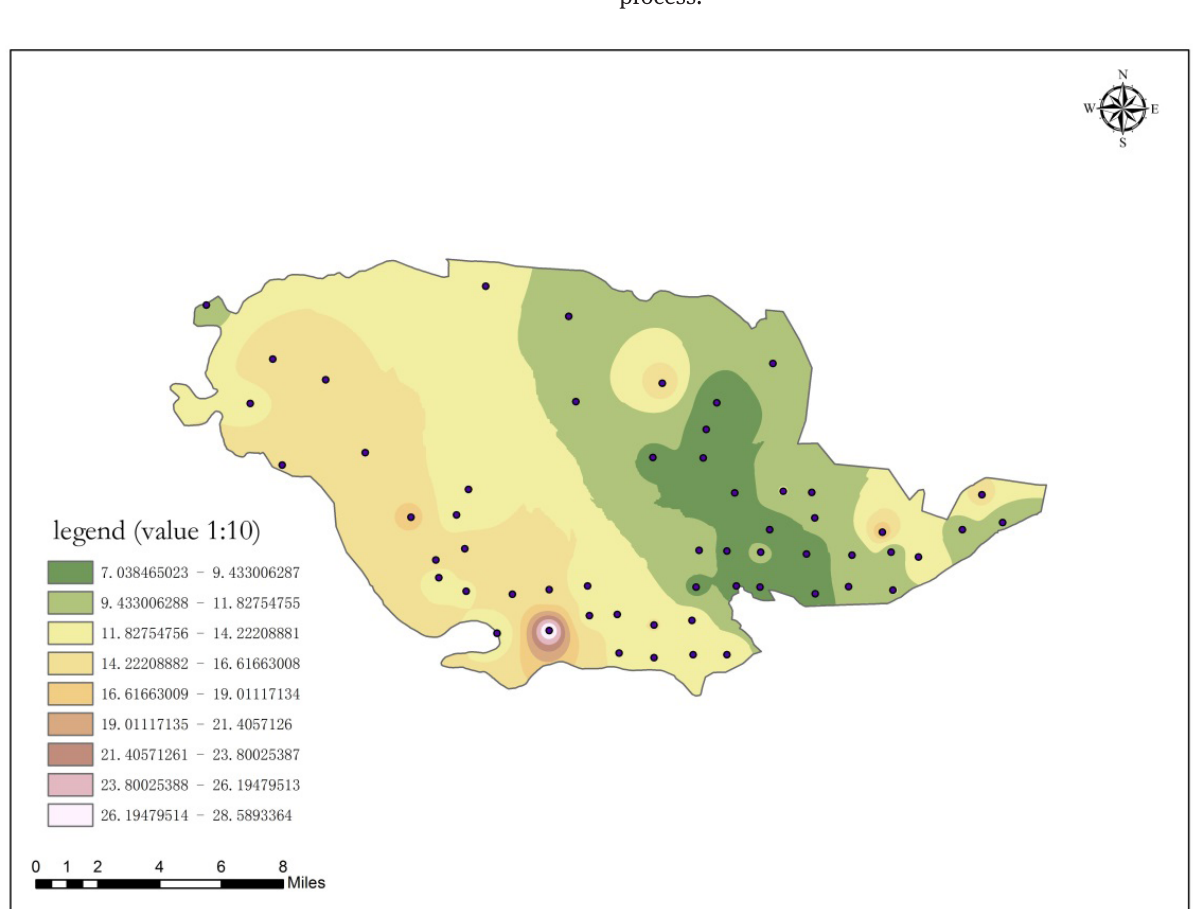
Figure 5: Spatial distribution of the total ecological risk index of the Dongxihu